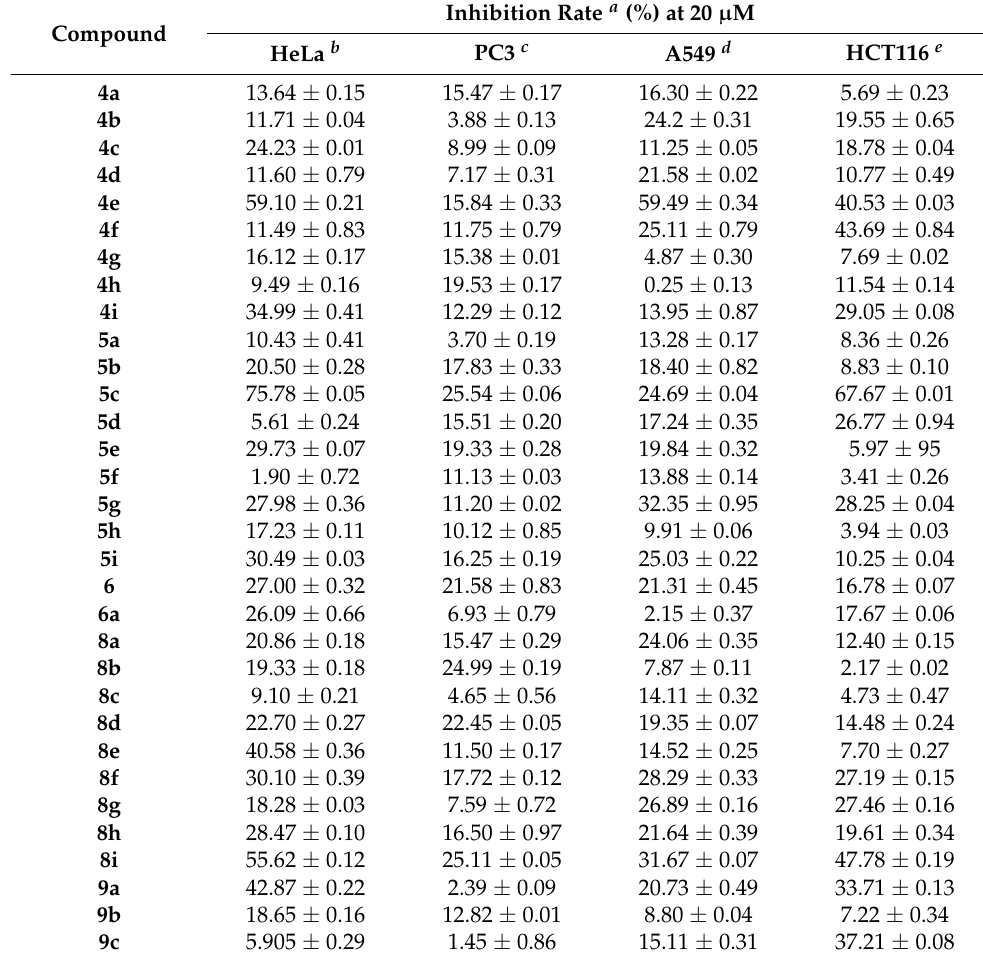
Table 1. Anti-proliferative activities of the synthesized compounds against various cancer cell lines.